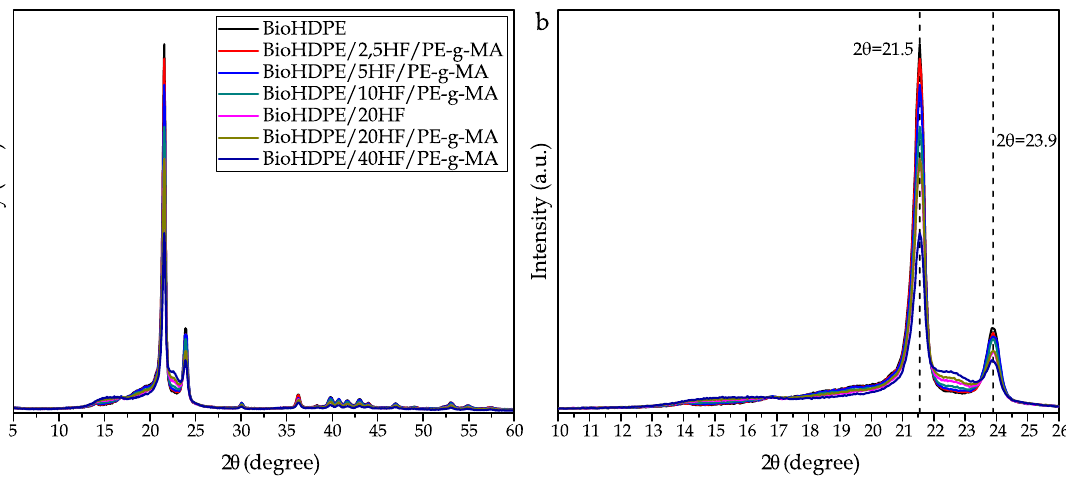
Figure 2. X-ray diffraction patterns for the BioHDPE/Hemp composites: ( a ) all range considered in the test; ( b ) detailed view of the main